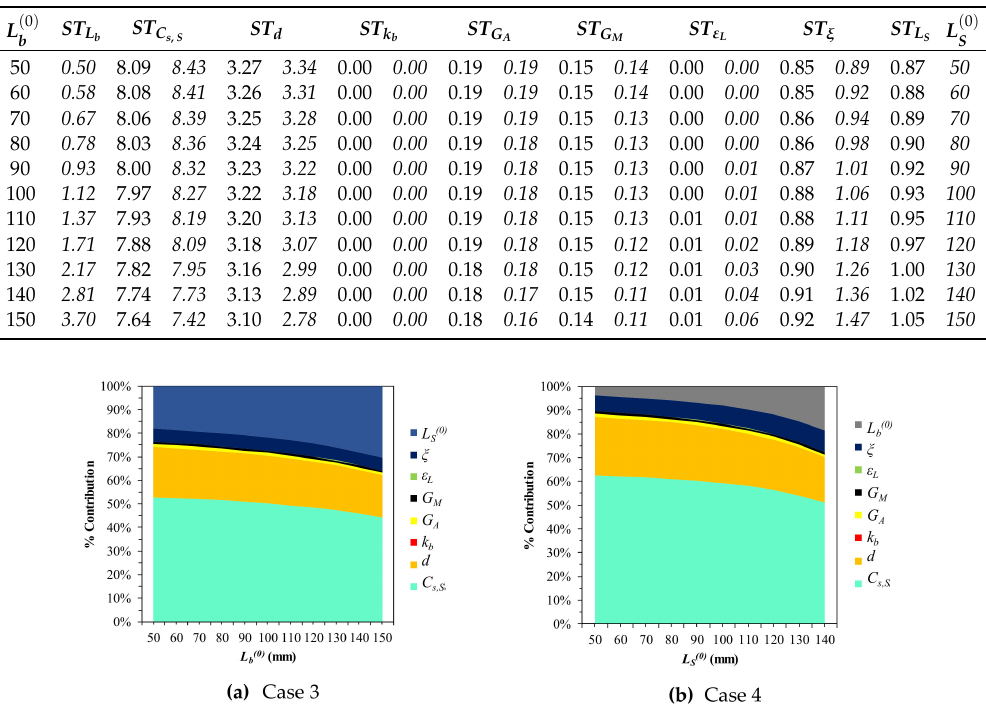
1E-1, L = 300): Case 3 (left) and Case 4 (right). ×